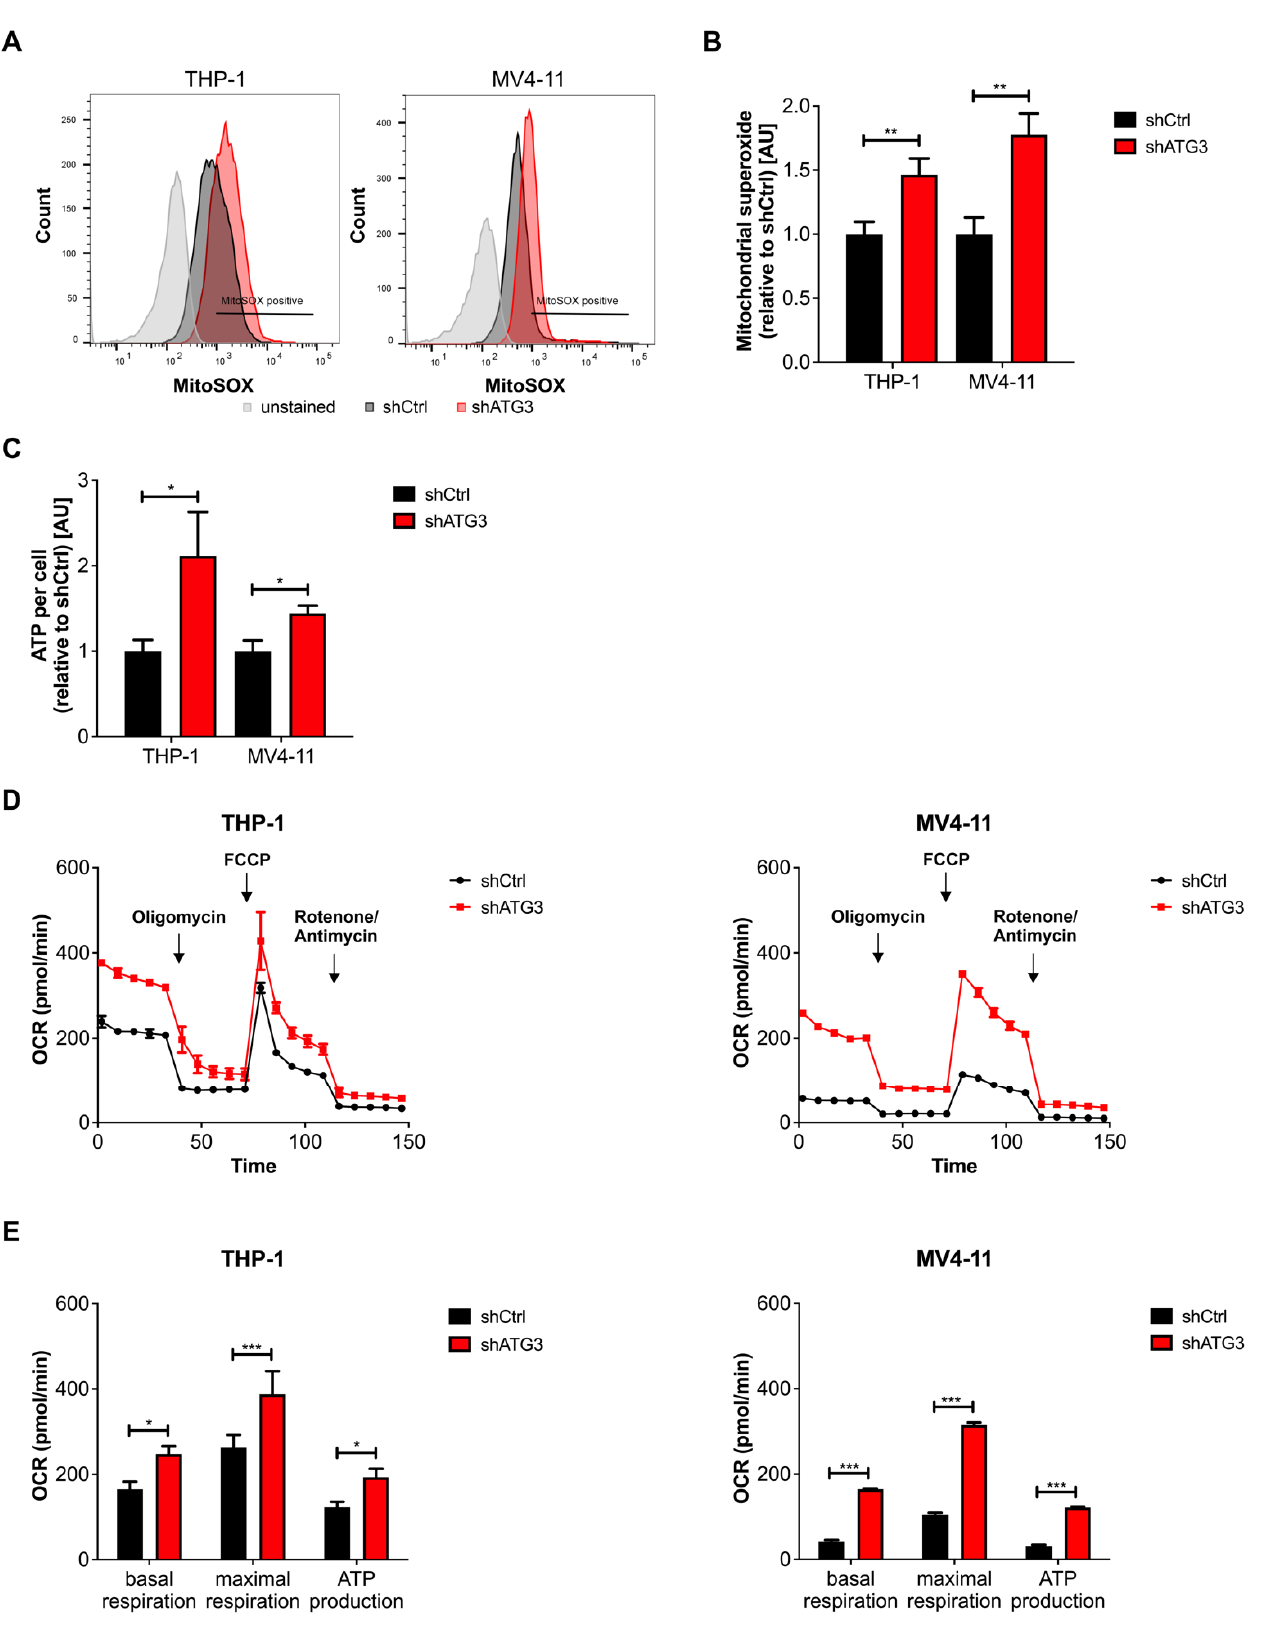
Figure 3. Loss of ATG3 increases mitochondrial activity in AML cells. ( A ) Mitochondrial superoxide levels were determined in THP-1 and MV4-11 cell lines by flow cytometry using MitoSOX dye. Representative flow cytometry images are shown. ( B ) Quantification of mitochondrial superoxide levels. ( C ) ATP levels of control and ATG3 knockdown cells were determined using Cell Titer Glo ® luminescent cell viability assay and normalized to cell number counted by trypan blue